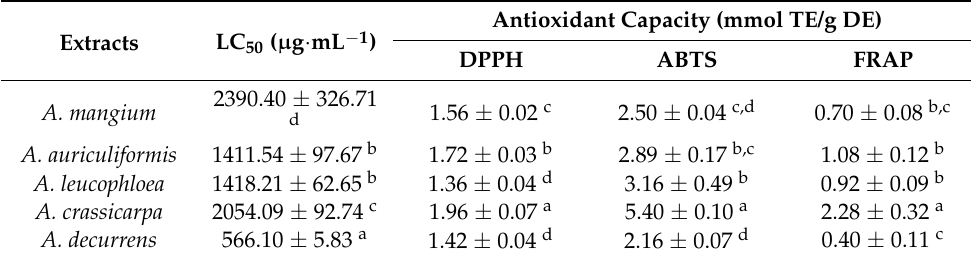
Table 2. Pharmacological activity of five Acacia heartwood methanolic extracts.